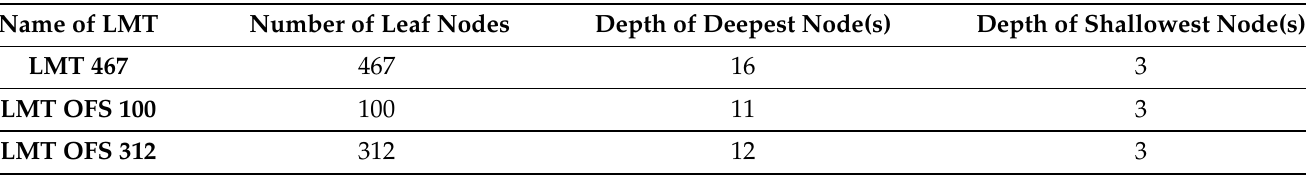
Table 5. Overview of the structures of the different LMTs. LMT OFS denotes LMTs where ordered feature splitting was utilized, while the number denotes the total number of leaf nodes the LMT has.